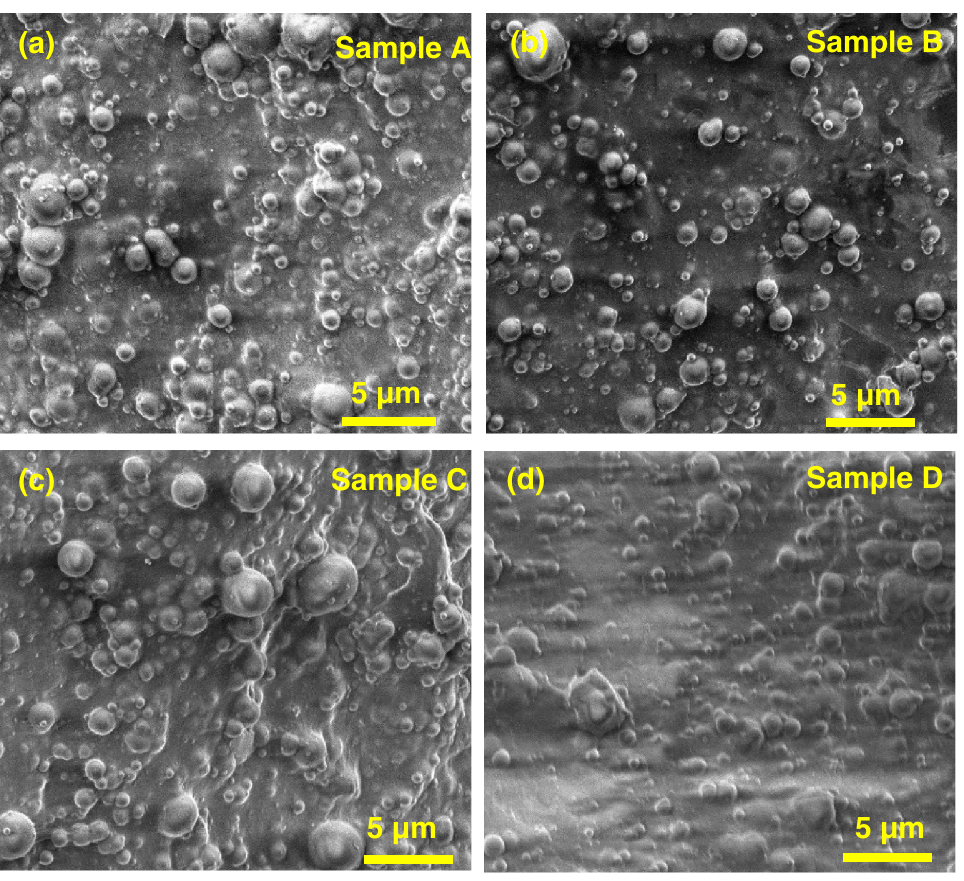
Figure 3. SEM images of samples A–D at a magnification of around × 10,000.